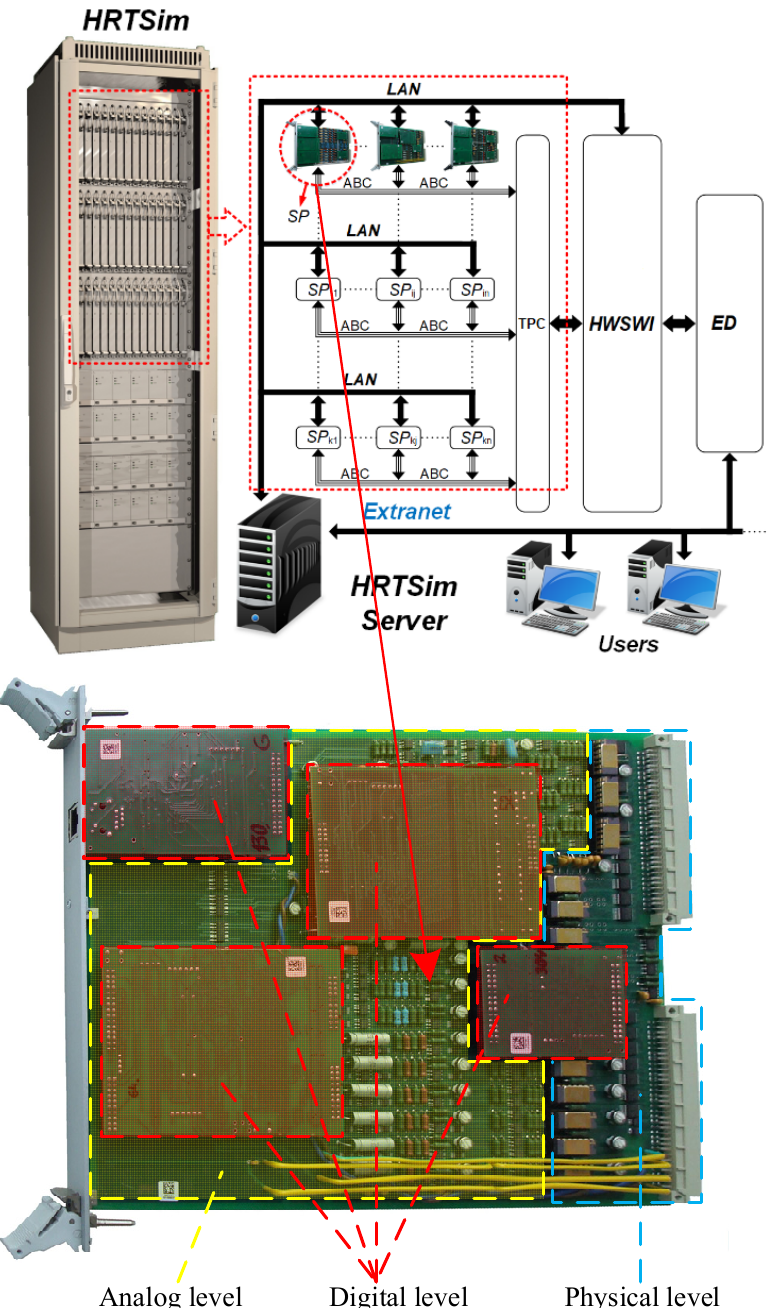
Figure 2. Block diagram of HRTSim configuration.